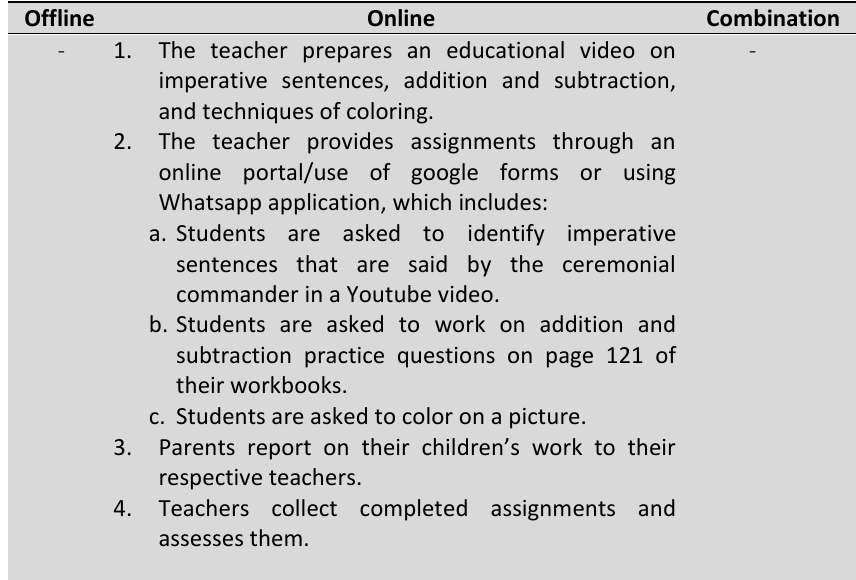
Table 1. The steps for the Year 2 lesson plan Theme